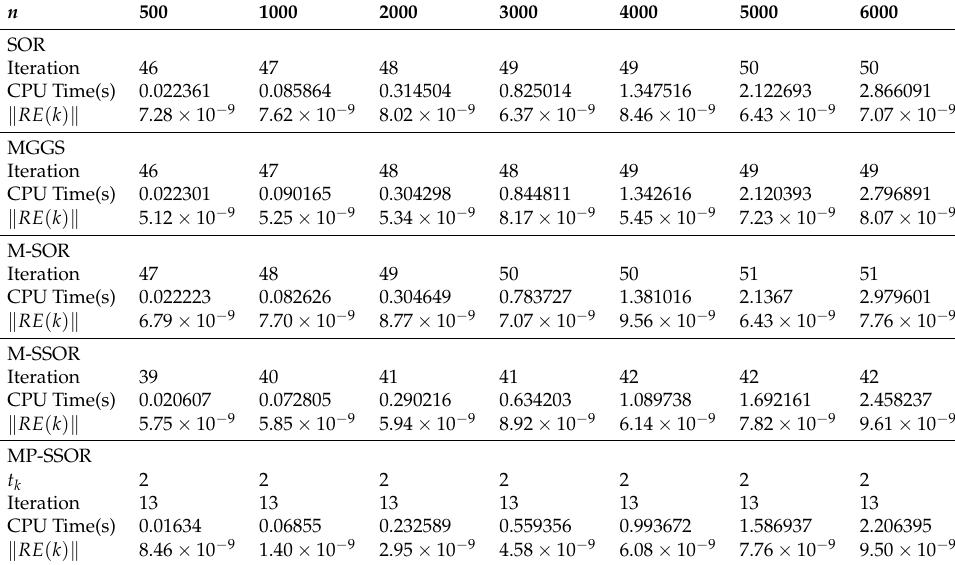
Table 1. Comparision of the iteration number and the CPU time in